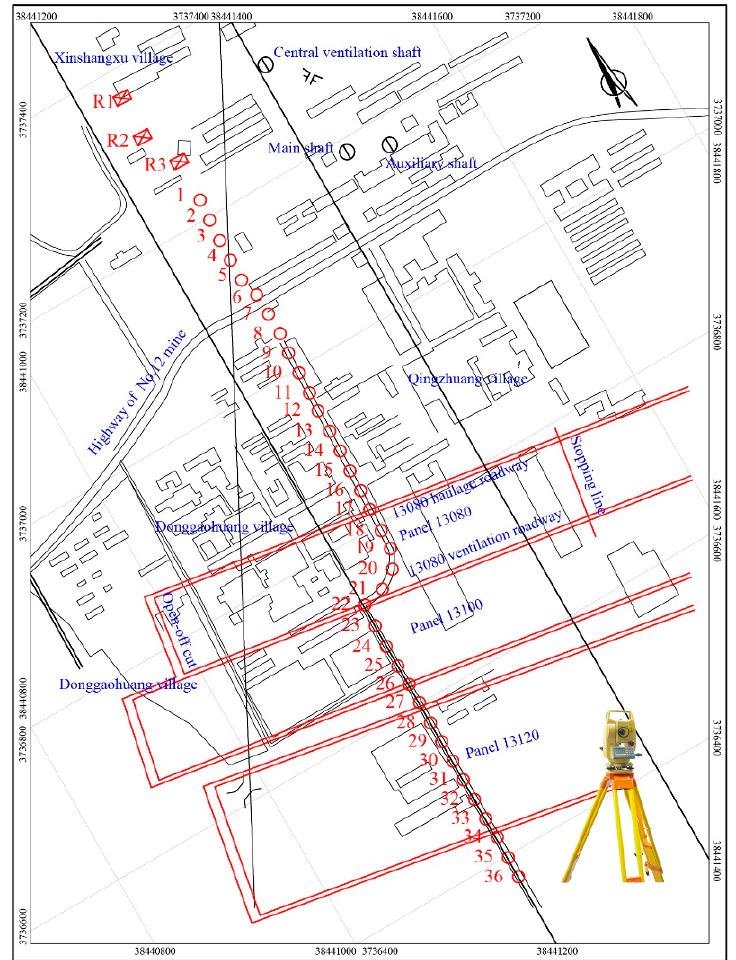
Figure 18. The sketch of the surface sagging observation line layout.